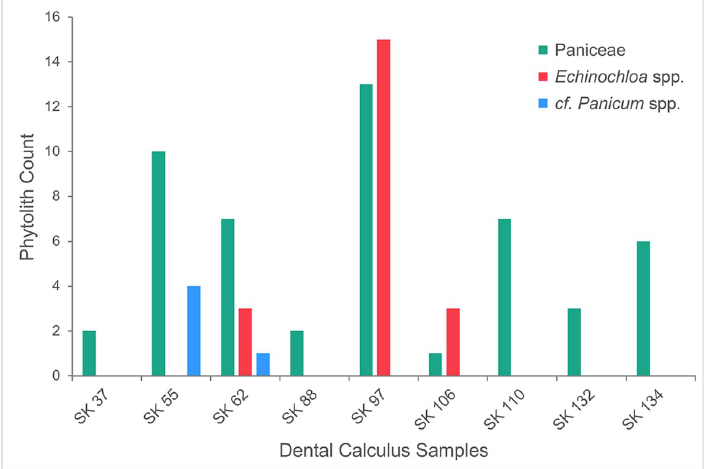
Fig 8. I NTERDIGITATE phytolith abundance and taxonomic classification. Taxonomic specificity of I NTERDIGITATE phytoliths present in dental calculus samples from KDK1 Middle Neolithic period individuals.